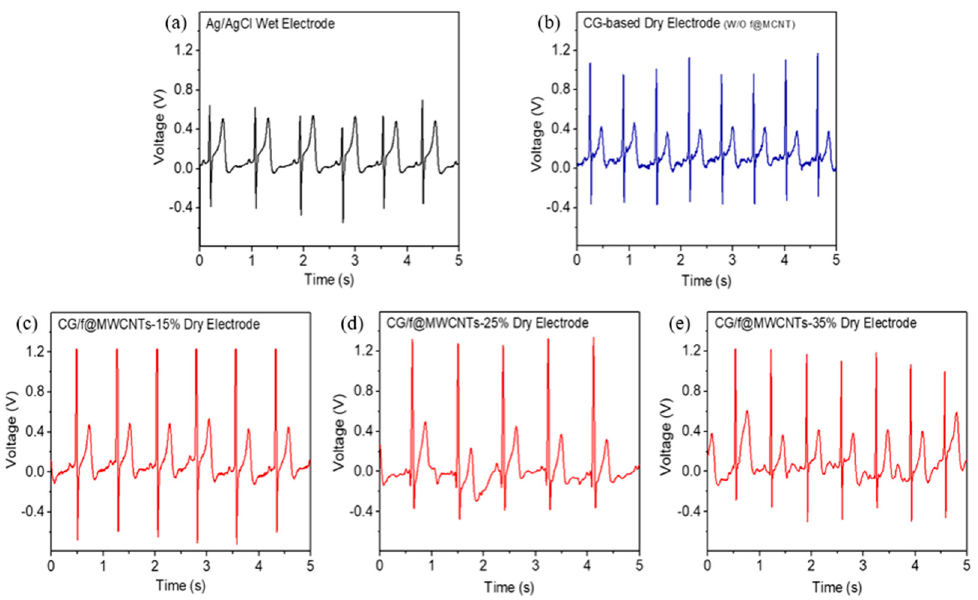
ff erent types of electrodes. ( a ) Conventional Ag / Figure 7. The chest ECG signals recorded by the different types of electrodes. ( a ) Conventional Figure 7. The chest ECG signals recorded by the di